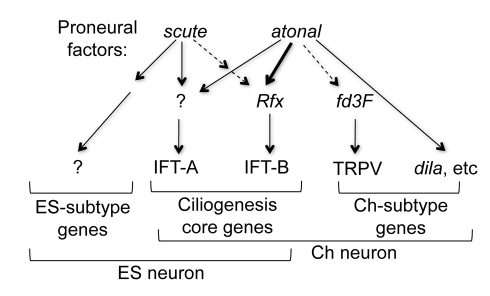
Summary of proposed regulatory interactions.Summary of proposed interactions leading from proneural genes to neuronal subtype differentiation. Solid and dashed arrows represent putative direct and indirect regulation, respectively. ato and ac regulate shared and unique aspects of sensory neuron differentiation. Ch ciliary specialisation is regulated by ato via several routes. (1) ato regulates a Ch-specific intermediate transcriptional regulatory (fd3F) that in turn regulates specialised aspects of sensory ciliary function. (2) ato regulates at least one differentiation gene directly (dila). (3) Rfx regulates a subset of ciliogenesis genes (including IFT-B genes) shared between sensory lineages, but differences in Rfx regulation by proneural genes ato and sc (only ato regulates Rfx directly) modulate these aspects. (4) The regulation of other aspects of differentiation and ciliogenesis (including IFT-A genes) does not depend on Rfx, suggesting further intermediate regulators remain to be discovered.